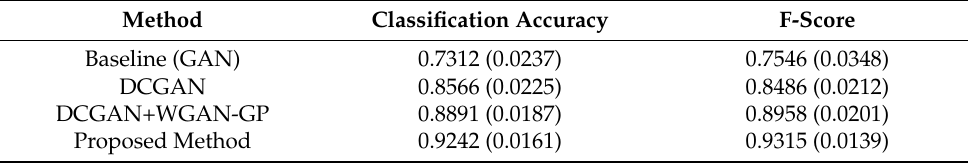
Table 3. Classification result for the results of generative models. avg. (± std.).